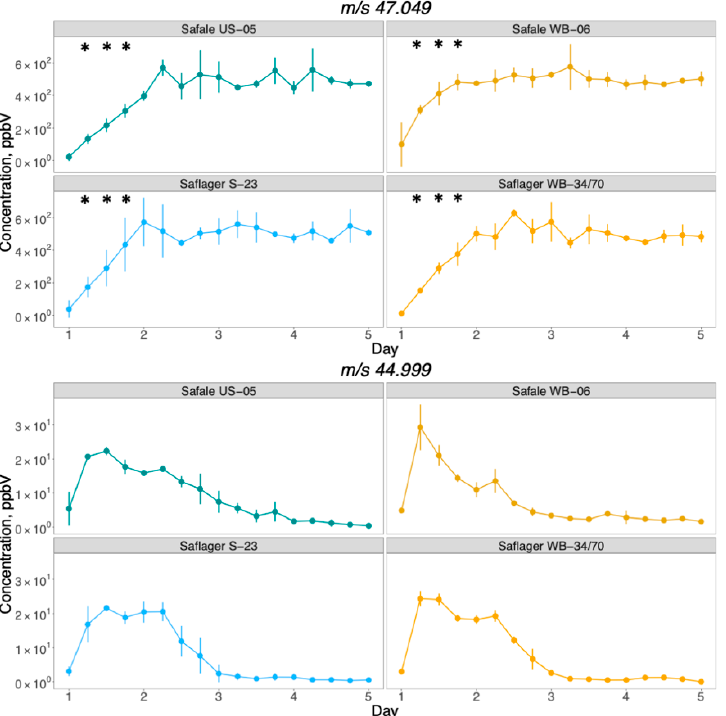
Figure 5. Mean concentration (ppbV) of ethanol ( m / z 47.049 ) and carbon dioxide ( m / z 44.999 ) during fermentation by commercially available yeast: Saccharomyces cerevisiae strain SafAle US-05, Saccharomyces cerevisiae var Diastaticus strain SafAle WB-06 and Saccharomyces pastorianus strains SafLager S-23 and SafLager W-34/70. Data presented as mean ± standard deviation of seven independent measurements. Asterisk (*) reflects statistically significant differences between